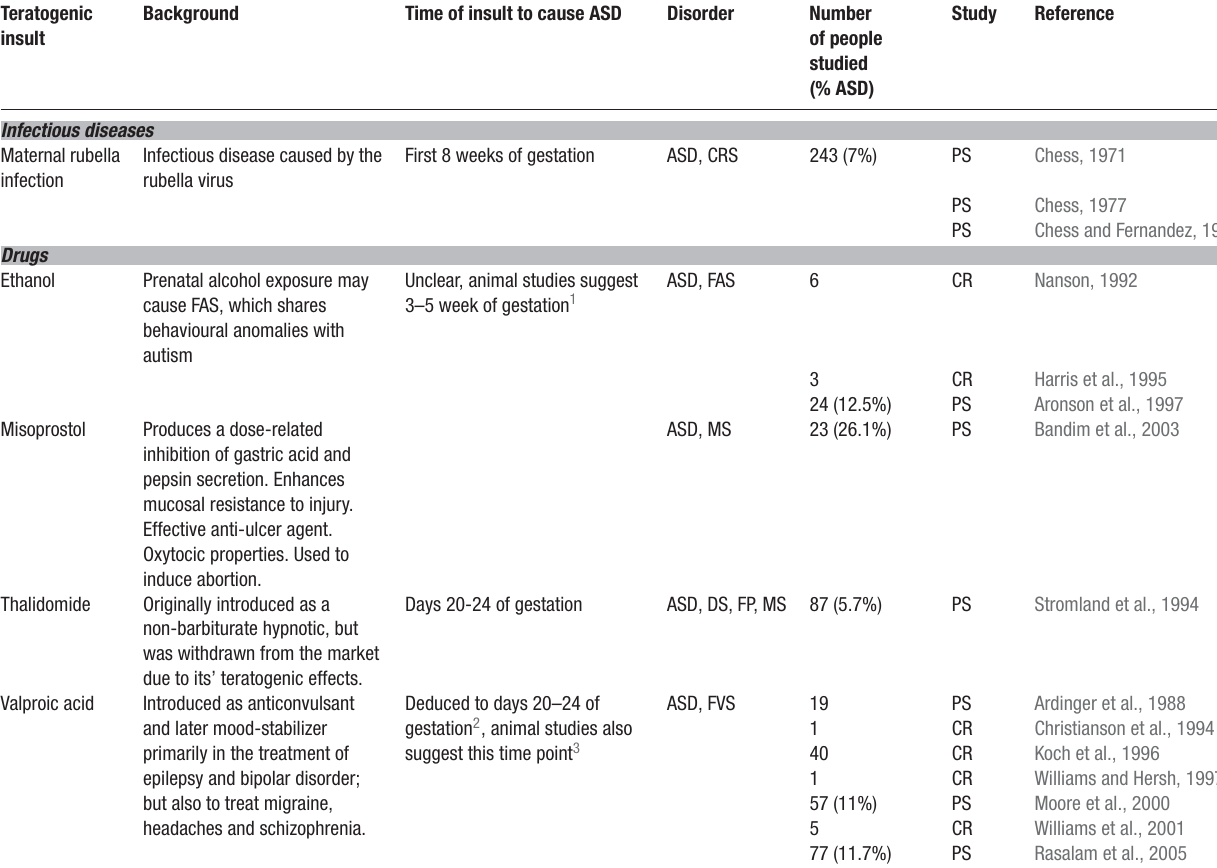
Table 1 . Potential environmental triggers for autism. Teratogenic